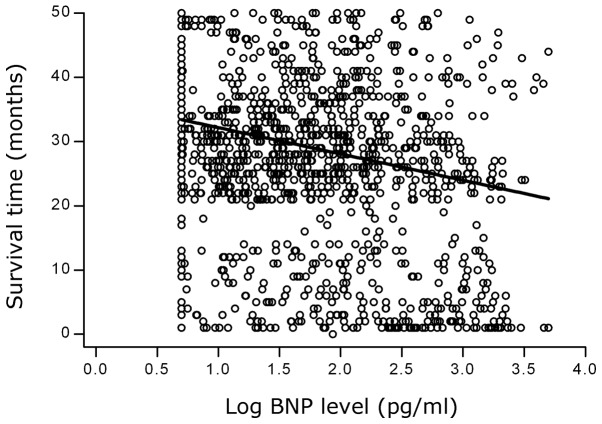
Scatter plot showing the correlation between the logBNP levels and the survival times in all the patients. BNP, brain natriuretic peptide.